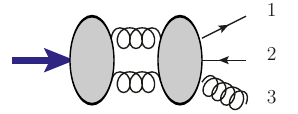
Figure 8. A unitarity cut for the one-loop form factor